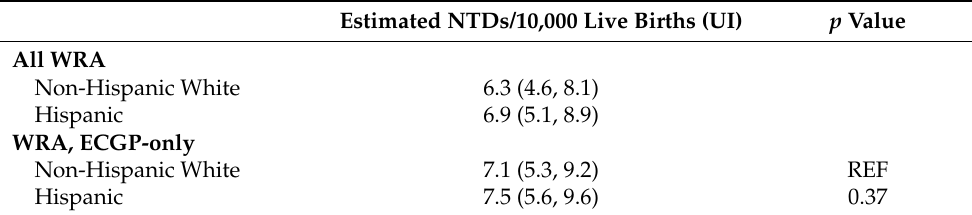
Table 6. Model-based estimation of neural tube defect (NTD) risk from red blood cell (RBC) folate dis- tributions, with estimated NTD rates per 10,000 live births (uncertainty interval) post-implementation of corn masa fortification (NHANES a